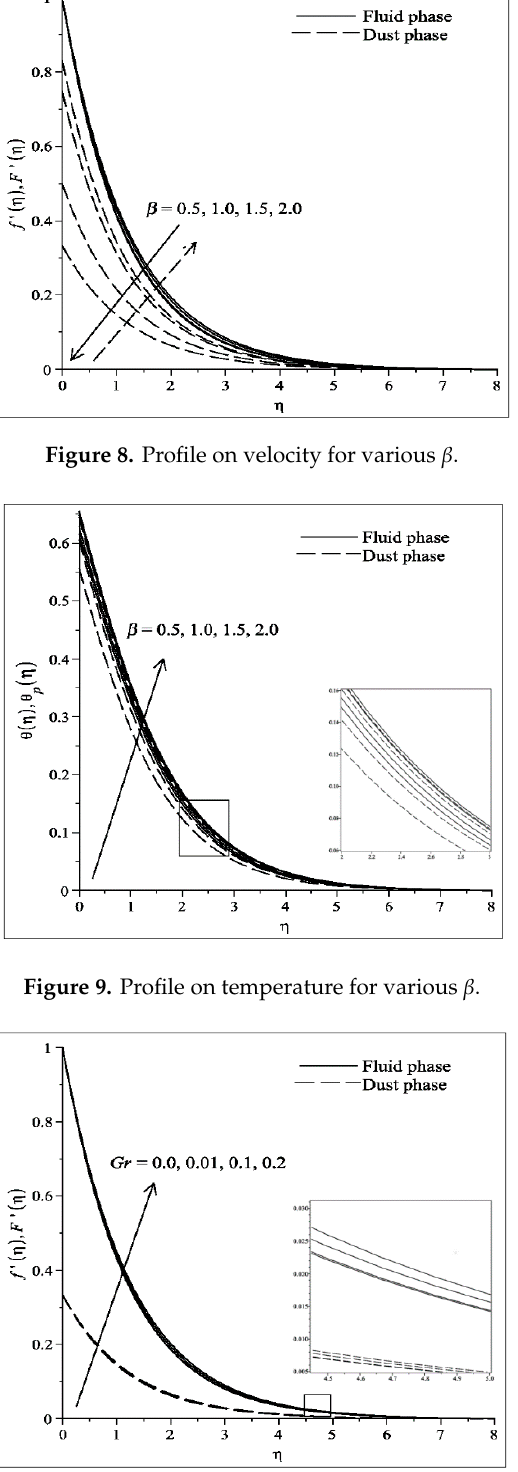
Figure 10. Profile on velocity for various .